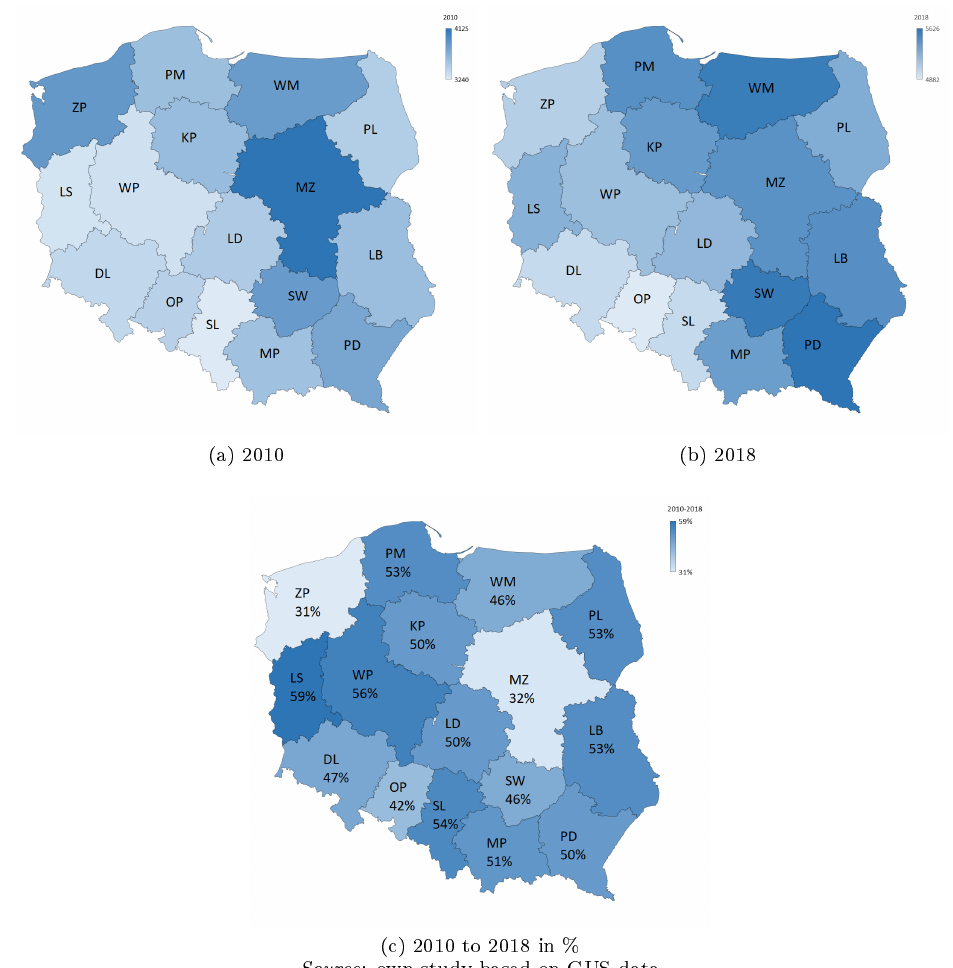
Figure 3: Government expenditure per capita by voivodeship and its increase (%) in 2010(cid:21)2018, PLN